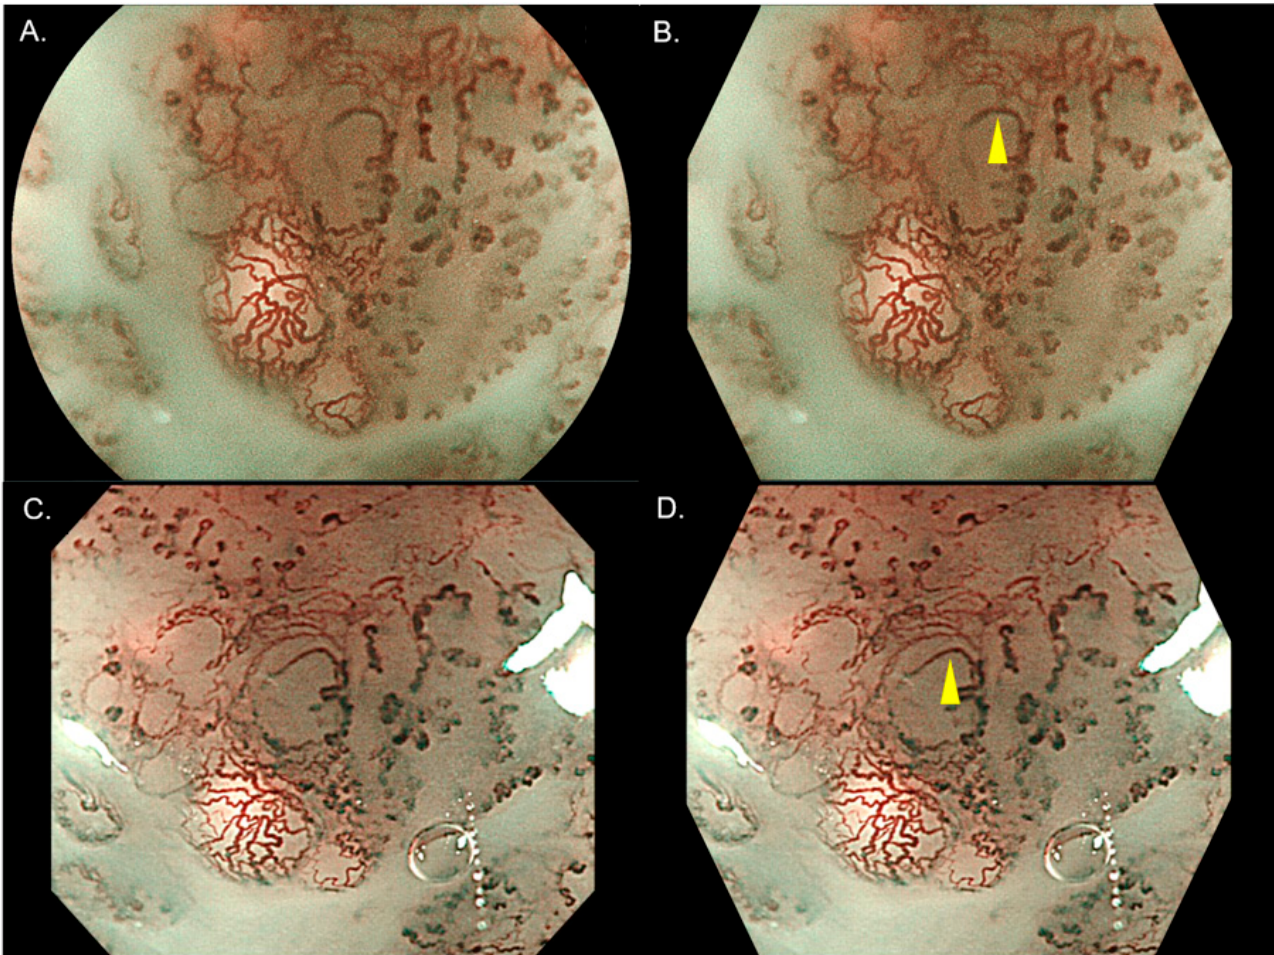
Figure 2. Standardization of the ME-BLI and ME-NBI images for review. ME-BLI ( A ) and ME-NBI ( C ) images were standardized to the same shape ( B , D ) to reduce the bias. The calibers of some B2 vessels in ME-BLI (yellow arrows) appeared larger than those in ME-NBI. ME-BLI, magnifying endoscopy with blue light imaging; ME-NBI, magnifying endoscopy with narrow band imaging.